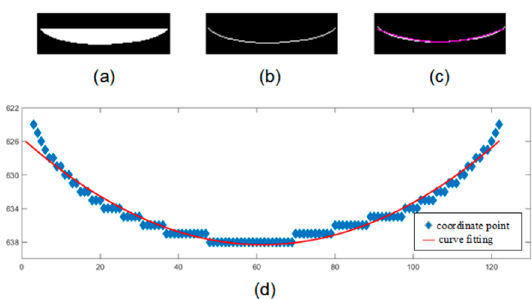
Figure 16. Fitting curves for ( a ) the standard concave meniscus. The images include ( b ) the level curve, ( c ) the fitting line (shown in red), and ( d ) an enlarged view of the resulting fit.